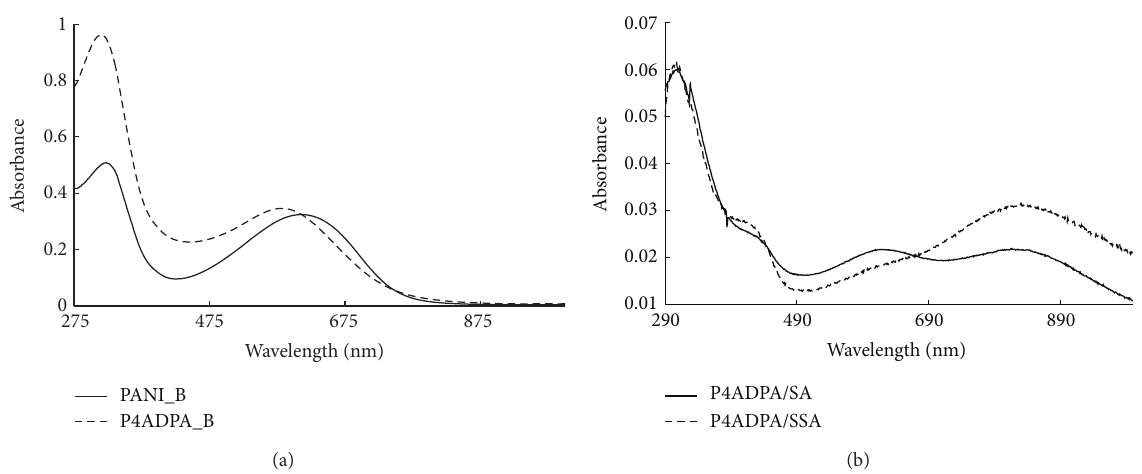
Figure 2: UV-vis spectra of (a) PANI B and P4ADPA B and (b) P4ADPA/SA and P4ADPA/SSA thin films.